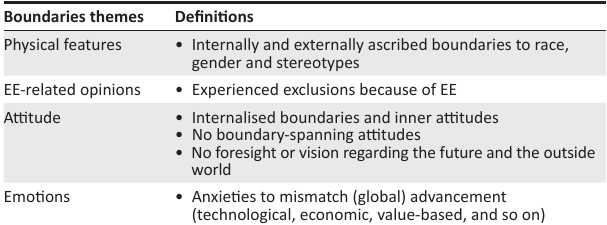
TABLE 3: Boundary themes.